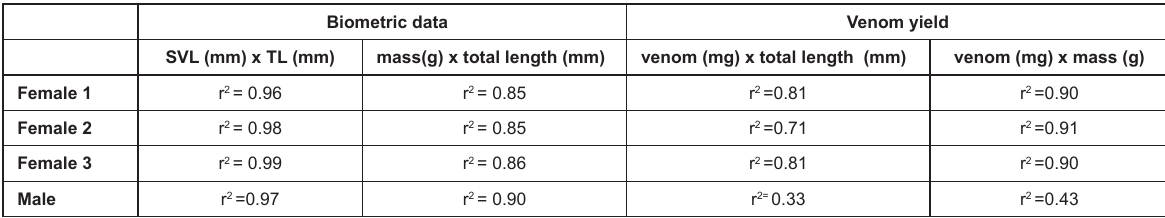
Figure 1. Growth in SVL (mm) (A); and weight (g) (B) of Bothrops insularis kept in